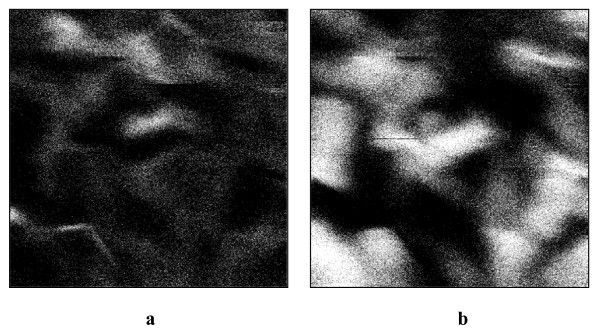
Zn (a) and W (b) rich emitting areas of a ZnO-ZnWO4 thin layer deposited by magnetron sputtering.